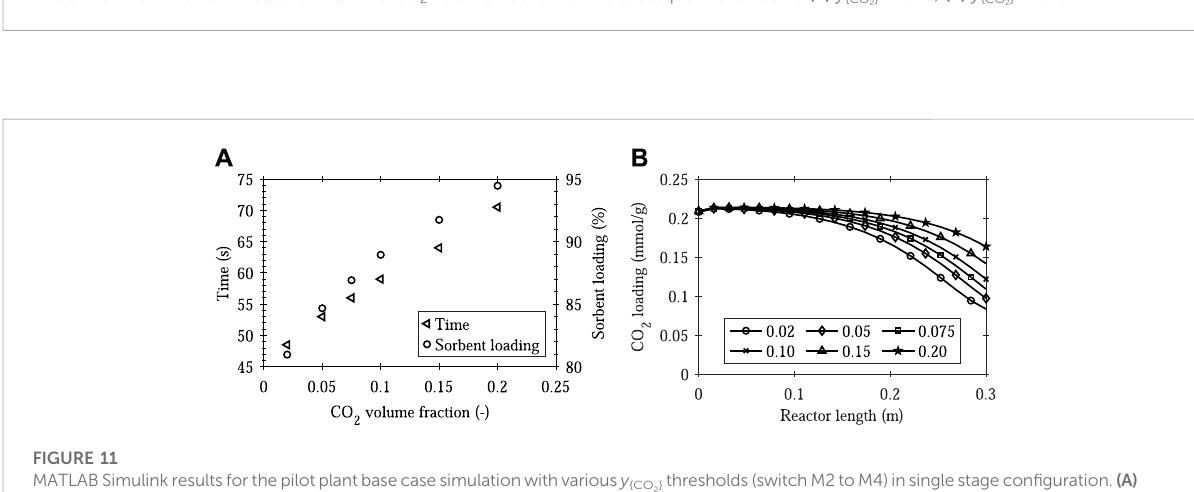
> 0.05attheoutlet ofthereaction chamber. 2 } > 0.10, (B) y > 0.15. {CO 2 } 2 }